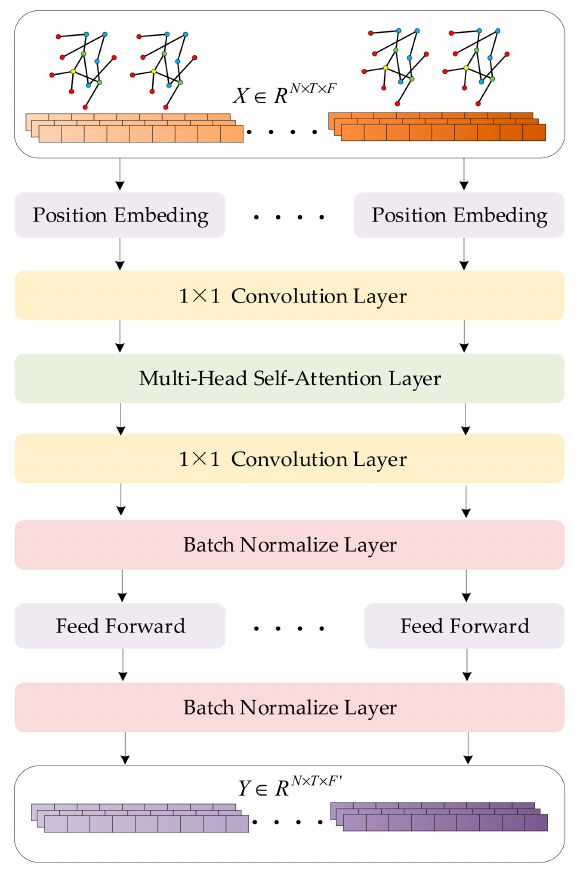
Figure 6. Structure diagram of